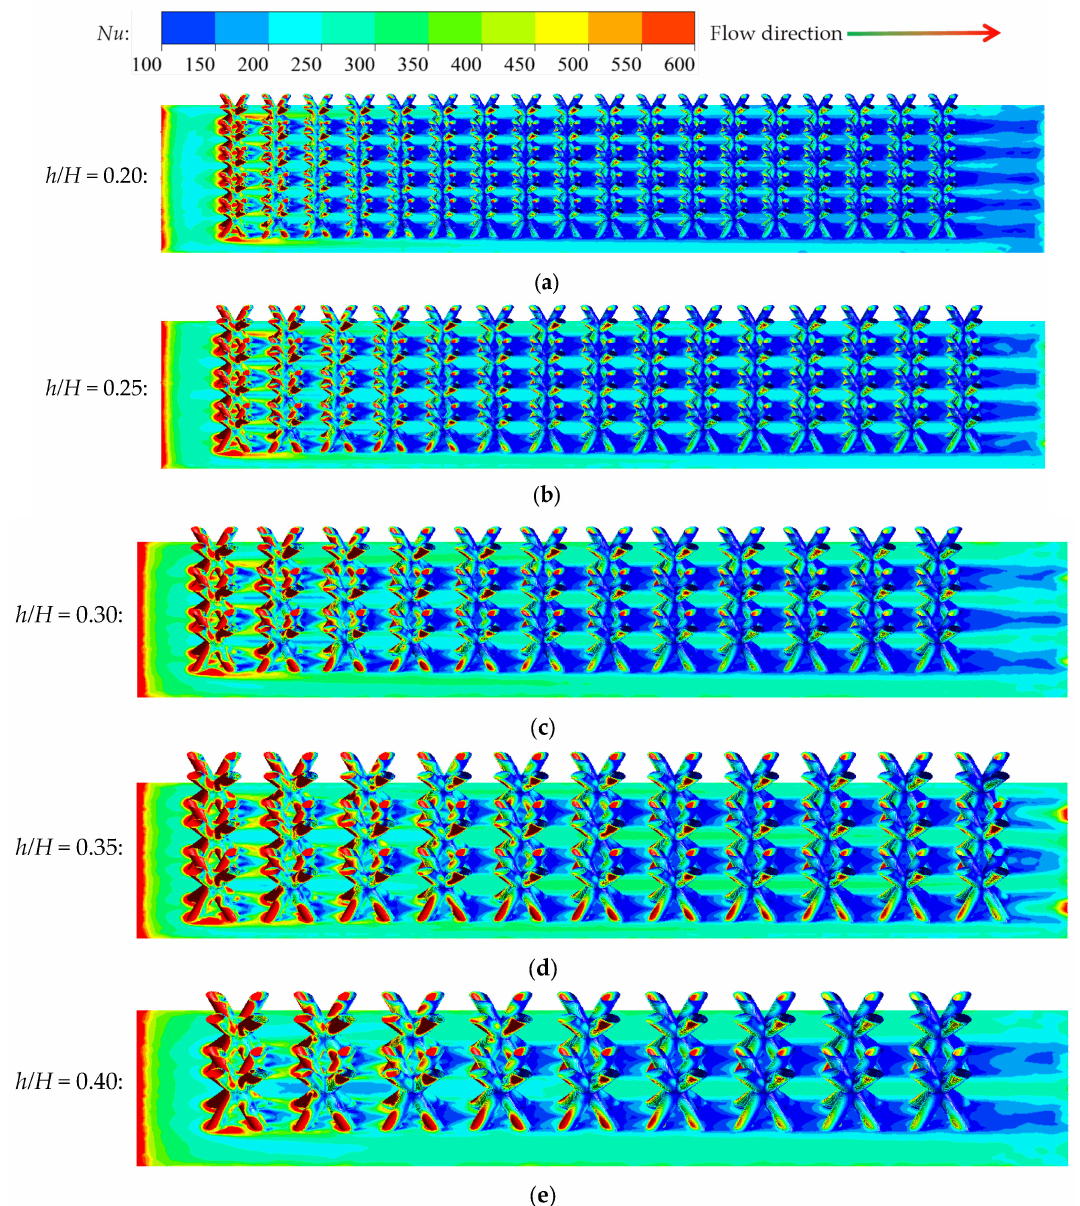
Figure 10. Heat transfer distributions of X-shaped truss array channels of Scheme 3 at different h/H ( Re = 30,000): ( a ) h/H = 0.20; ( b ) h/H = 0.25; ( c ) h/H = 0.30; ( d ) h/H = 0.35; ( e ) h/H =